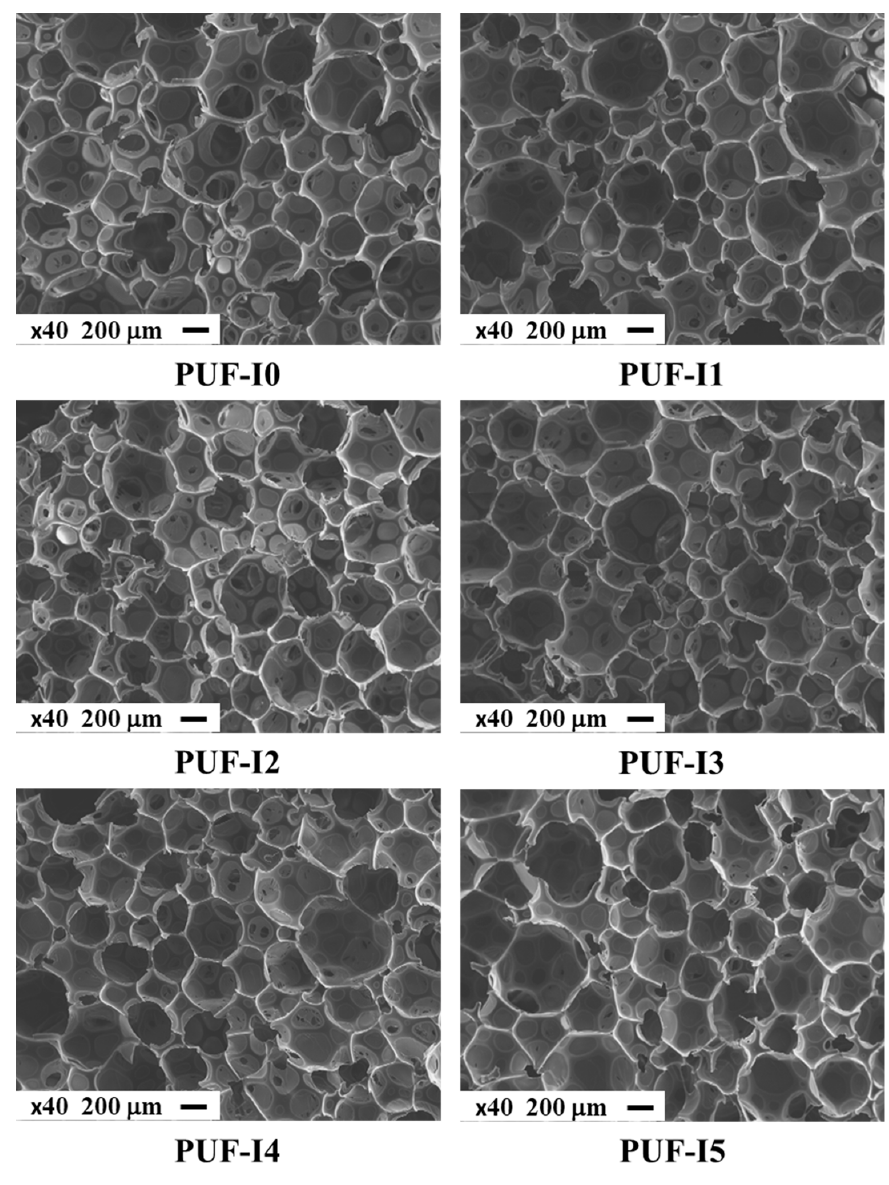
Figure 1. SEM images of the various FPUFs studied.